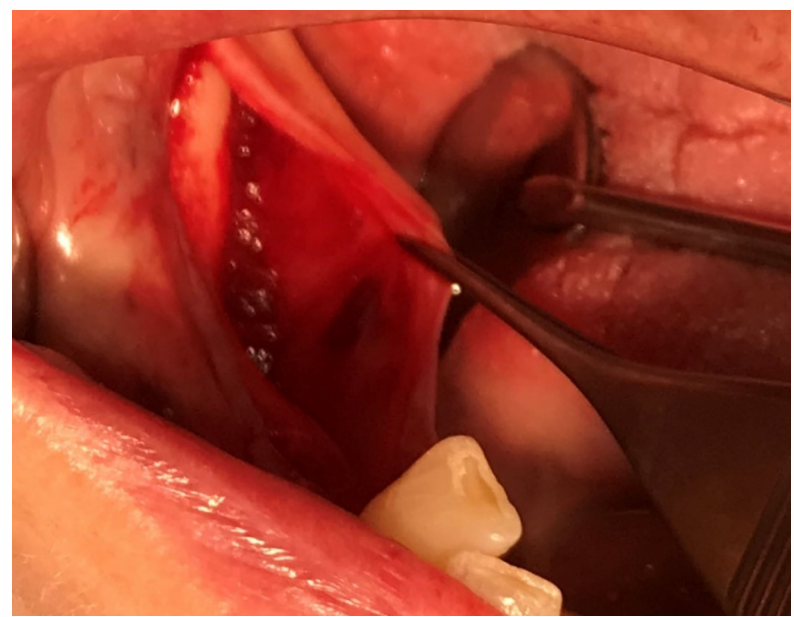
Figure 5. Flap advancement for sufficient cover of the bone block. The customized bone block was rehydrated in a 0.9% sodium chloride solution ac- cording to the manufacturer’s instructions (Zimmer-Biomet Dental, Palm Beach Gardens, FL, USA) to improve the ductility and reduce the risk of fracture [14]. In order to achieve a uniform penetration of the liquid, the block was transferred into a sterile syringe with the sodium chloride solution. Special concern was made to remove all air bubbles from the block [11,15] (Figure 6a,b).